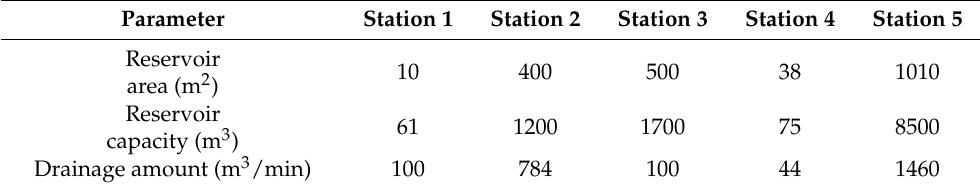
Table 3. Drainage pump station data.